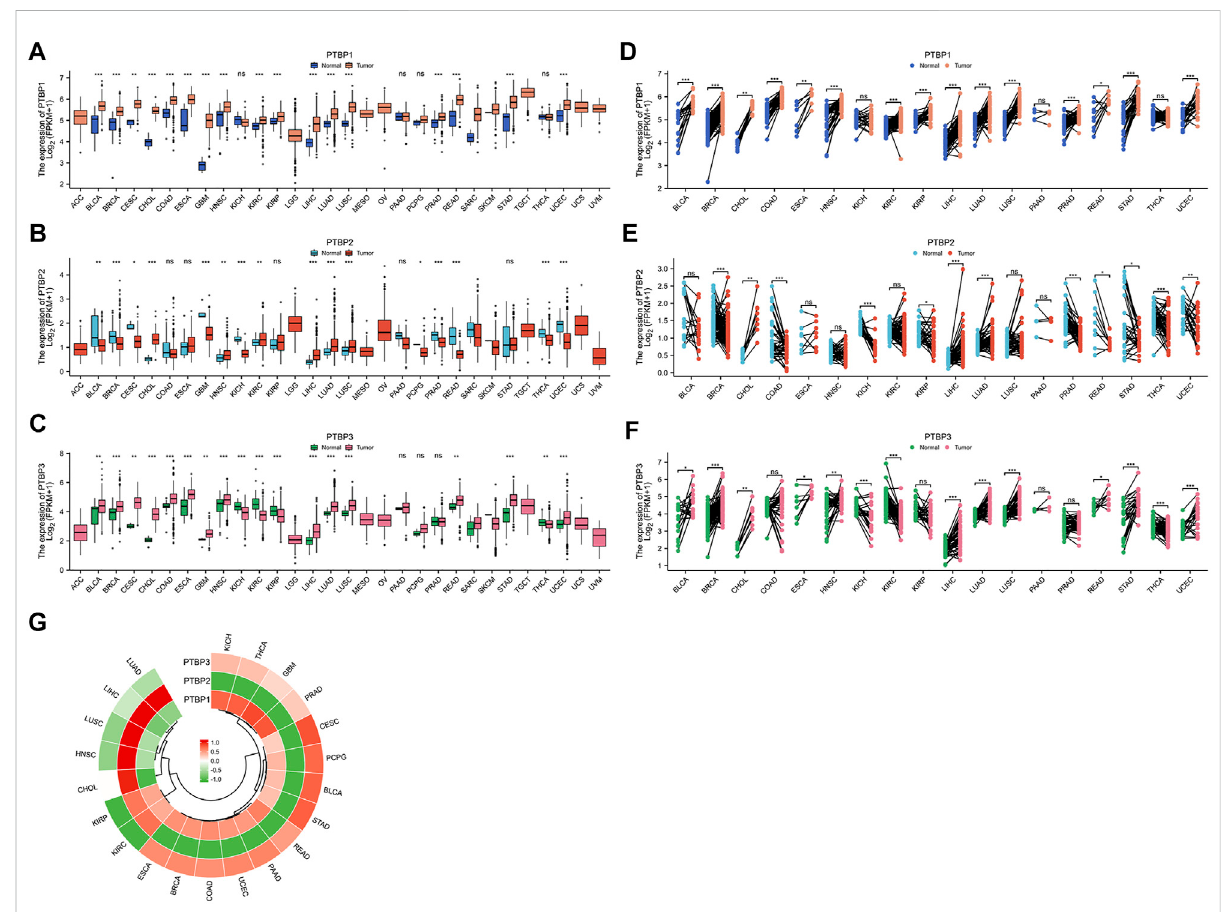
FIGURE 1 The expression levels of PTBP inpan-cancer tissues and the expression correlation among the three PTBP genes. RNA-seq data were obtained from the TCGA database. (A – C) Differential expression of PTBPs in unpaired samples of 30 tumor types. (D – F) Differential expression of PTBPs in pairedsamplesof30tumortypes(* p < 0.05;** p < 0.01;*** p < 0.001;ns:notsigni fi cant). (G) Correlationanalysisoftheexpressionsof PTBP1 , PTBP2 , and PTBP3 in various tumor